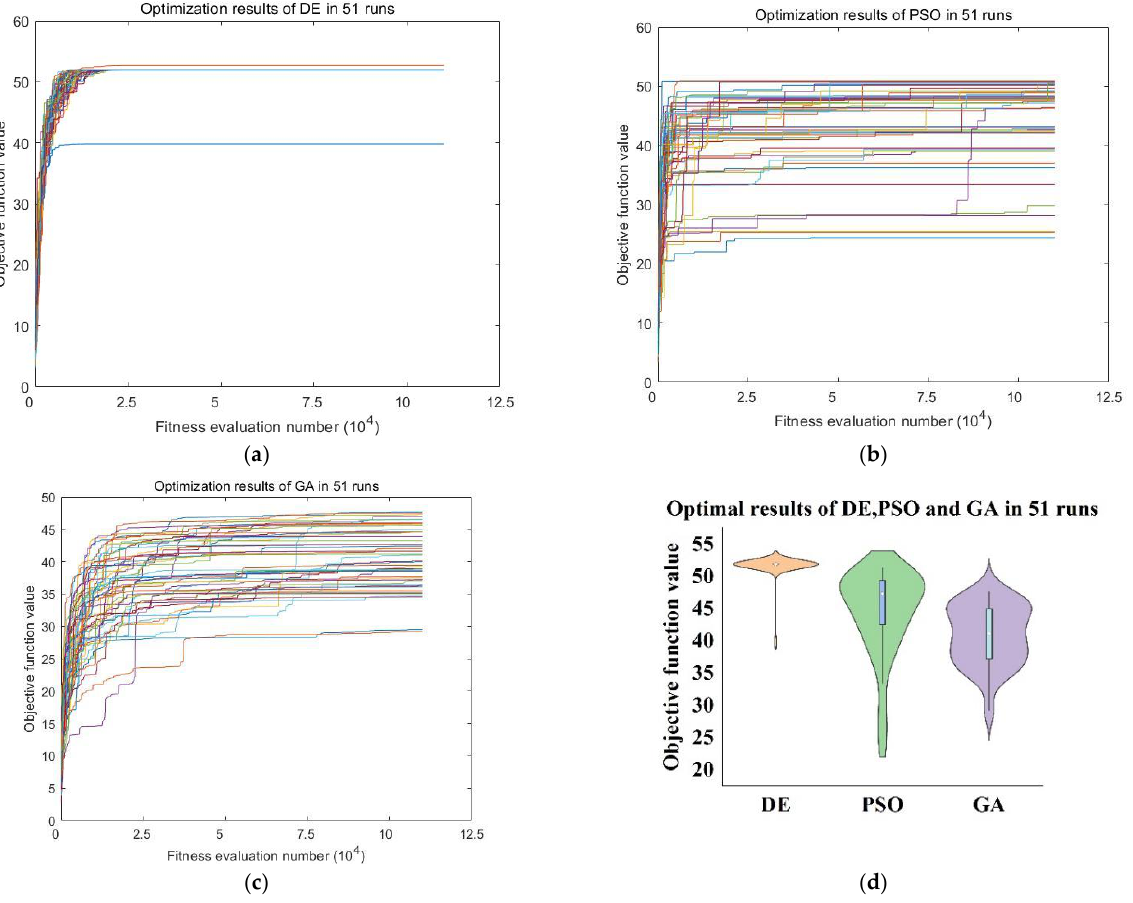
Figure 5. Convergence and statistics analysis of DE, PSO and GA within 50 runs. ( a – c ) show the convergence of DE, PSO, and GA, respectively. ( d ) suggests the distribution of the optimal OFV provided by DE, PSO and GA in 51